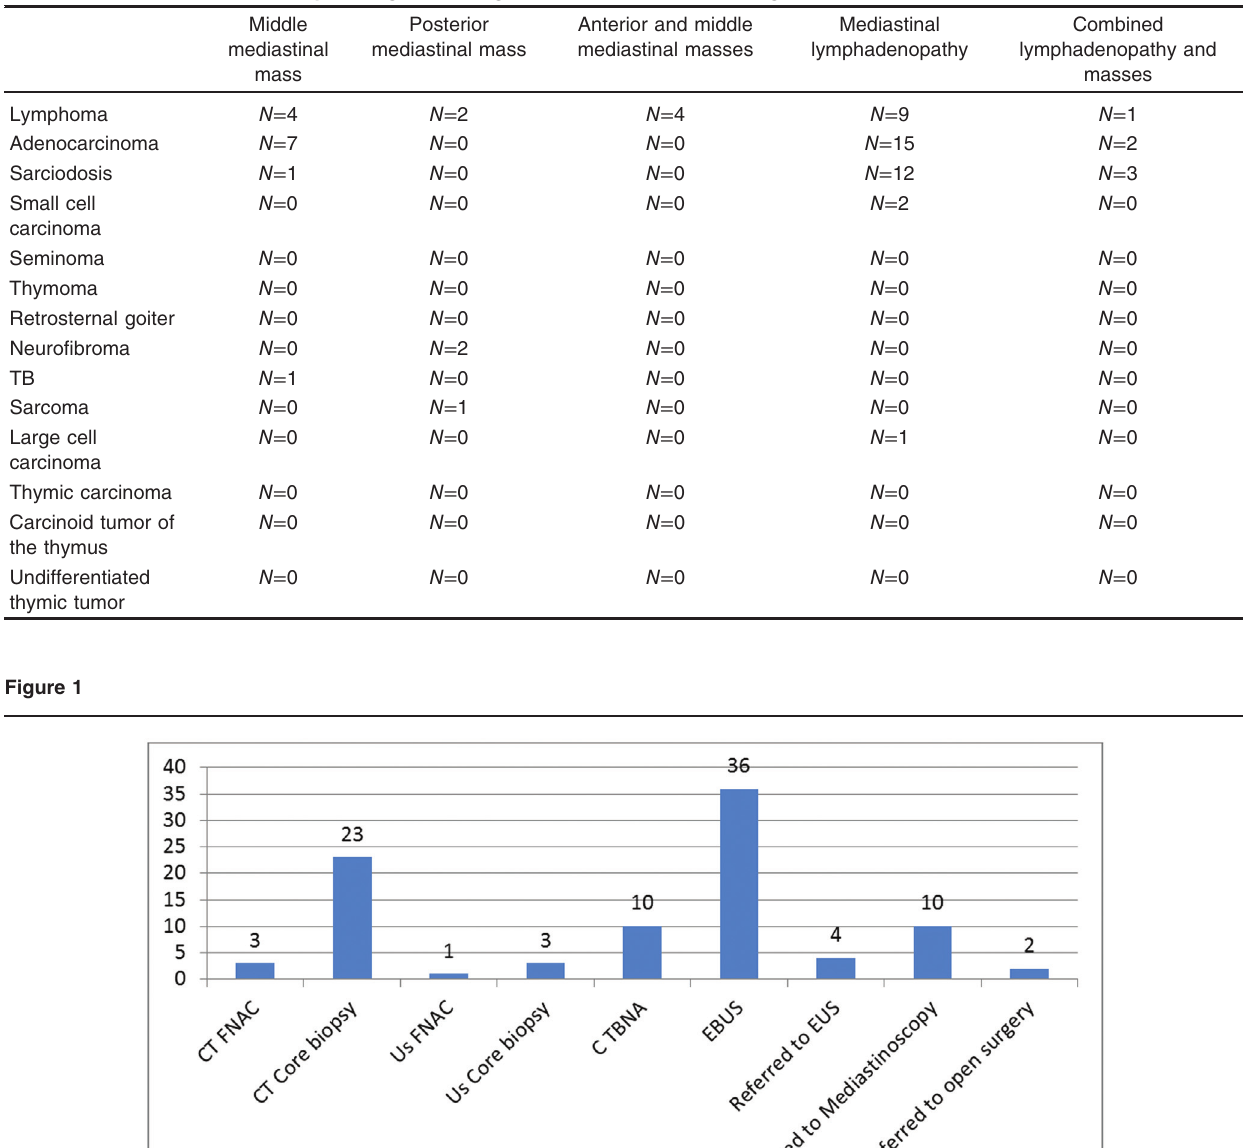
Table 4 Distribution of different pathological findings in different mediastinal regions